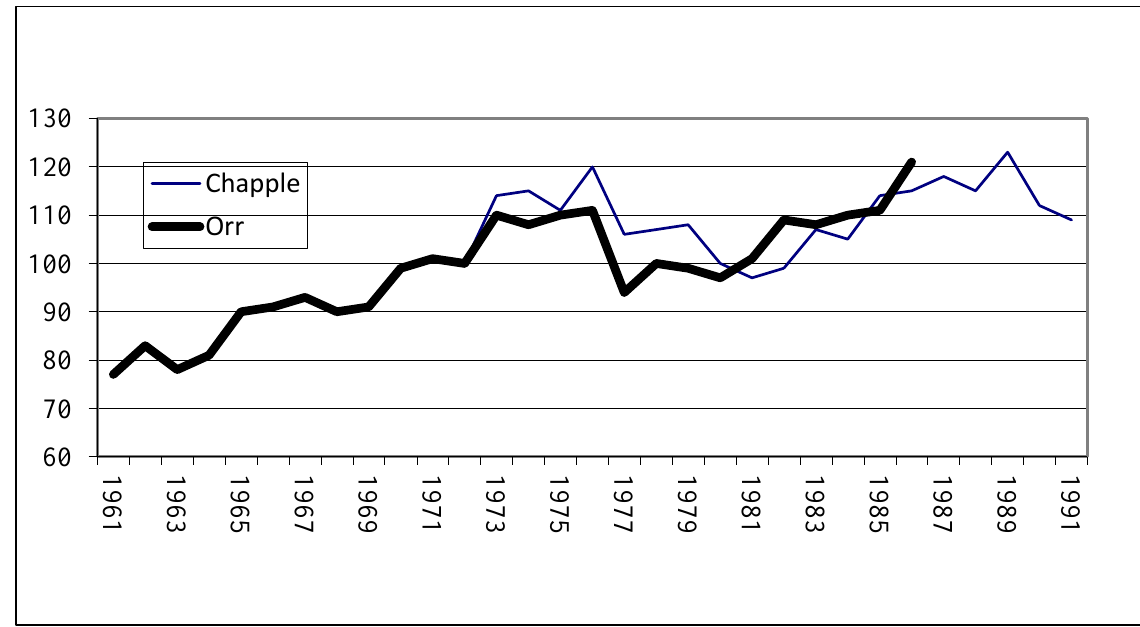
Figure 1 Total factor productivity in New Zealand construction, 1972=100 Source: Orr 1989; Chapple